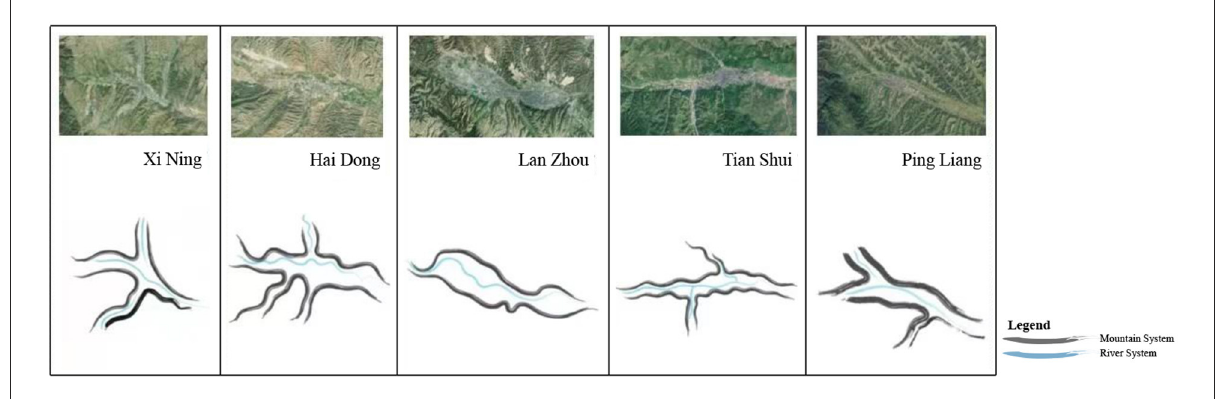
FIGURE2 Landscape pattern of semi-arid valley cities in northwestern China.